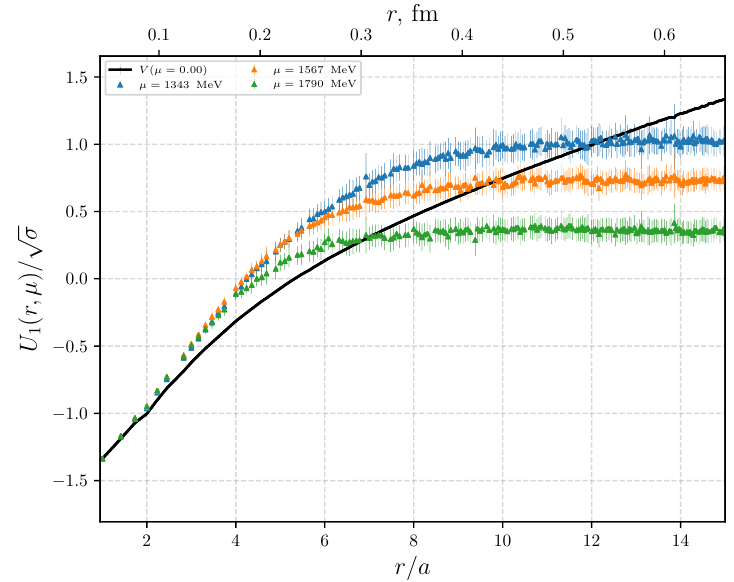
Figure 9 . The internal energy of a static quark-antiquark pair as a function of the distance for few values of the chemical potential under study. The black curve is the potential of static quark- antiquark pair at zero density and